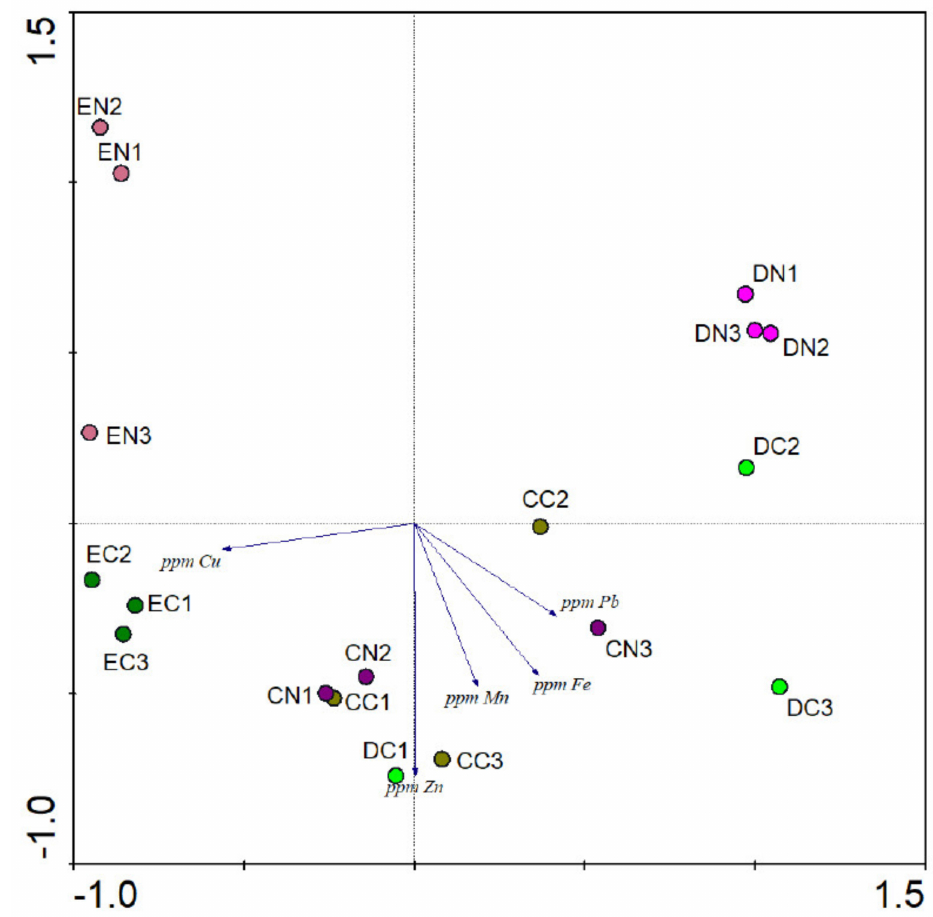
Figure 6. PCA ordination diagram showing the spatial arrangement of samples (points) with regard to the root concentra- tions in trace elements (arrows), plant species, and soil (contaminated or uncontaminated). CC= contaminated soil under C. salviifolius , CN= uncontaminated soil under C. salviifolius , DC= contaminated soil under D. viscosa , DN= uncontaminated soil under D. viscosa , EC= contaminated soil under E. pithyusa , EN= uncontaminated soil under E. pithyusa